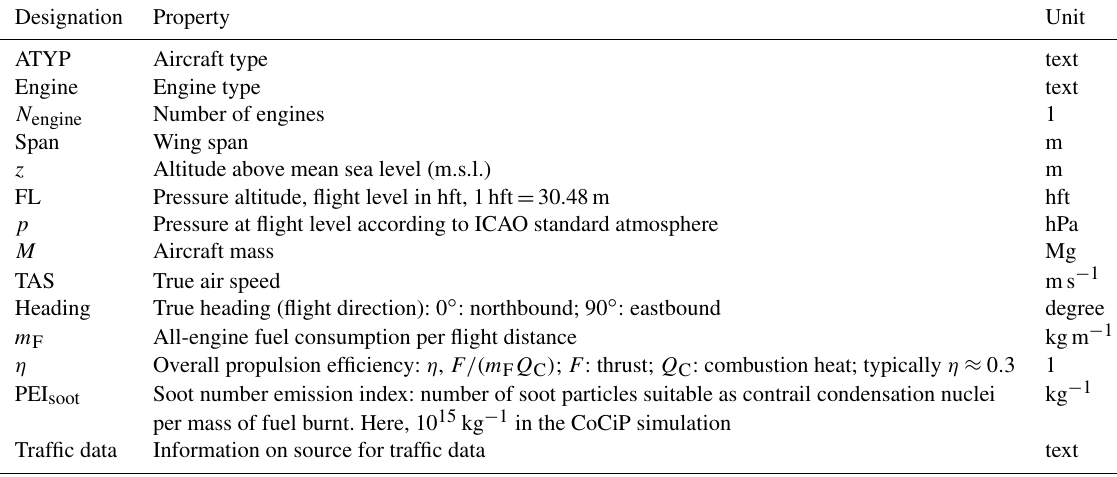
Table 1. Aircraft and engine.